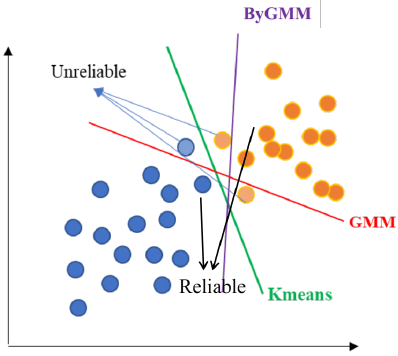
Figure 2. Graphical representation of unreliable and reliable labels.